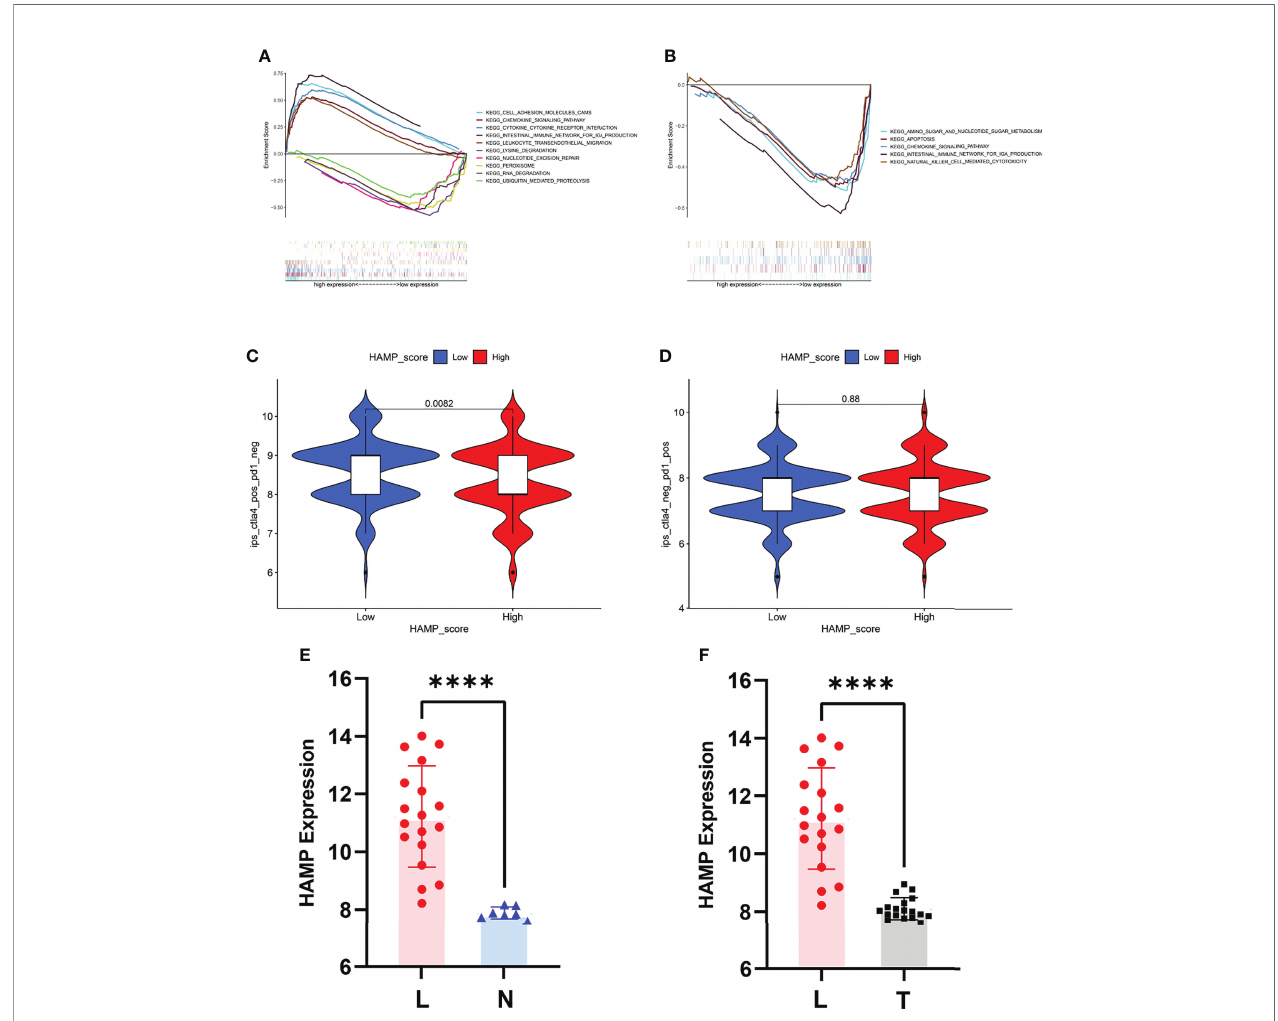
FIGURE 7 | Biological value of HAMP and the risk score. (A) GSEA for the risk score. (B) GSEA for HAMP. (C) Relationship between the expression of HAMP and CTLA4-based immunotherapy. (D) Relationship between the expression of HAMP and PD1-based immunotherapy. (E) HAMP expression between the liver metastasis and normal groups in GSE14297. (F) HAMP expression between liver metastasis and tumor groups in GSE14297. L represents liver metastasis, N represents normal, and T represents tumor.